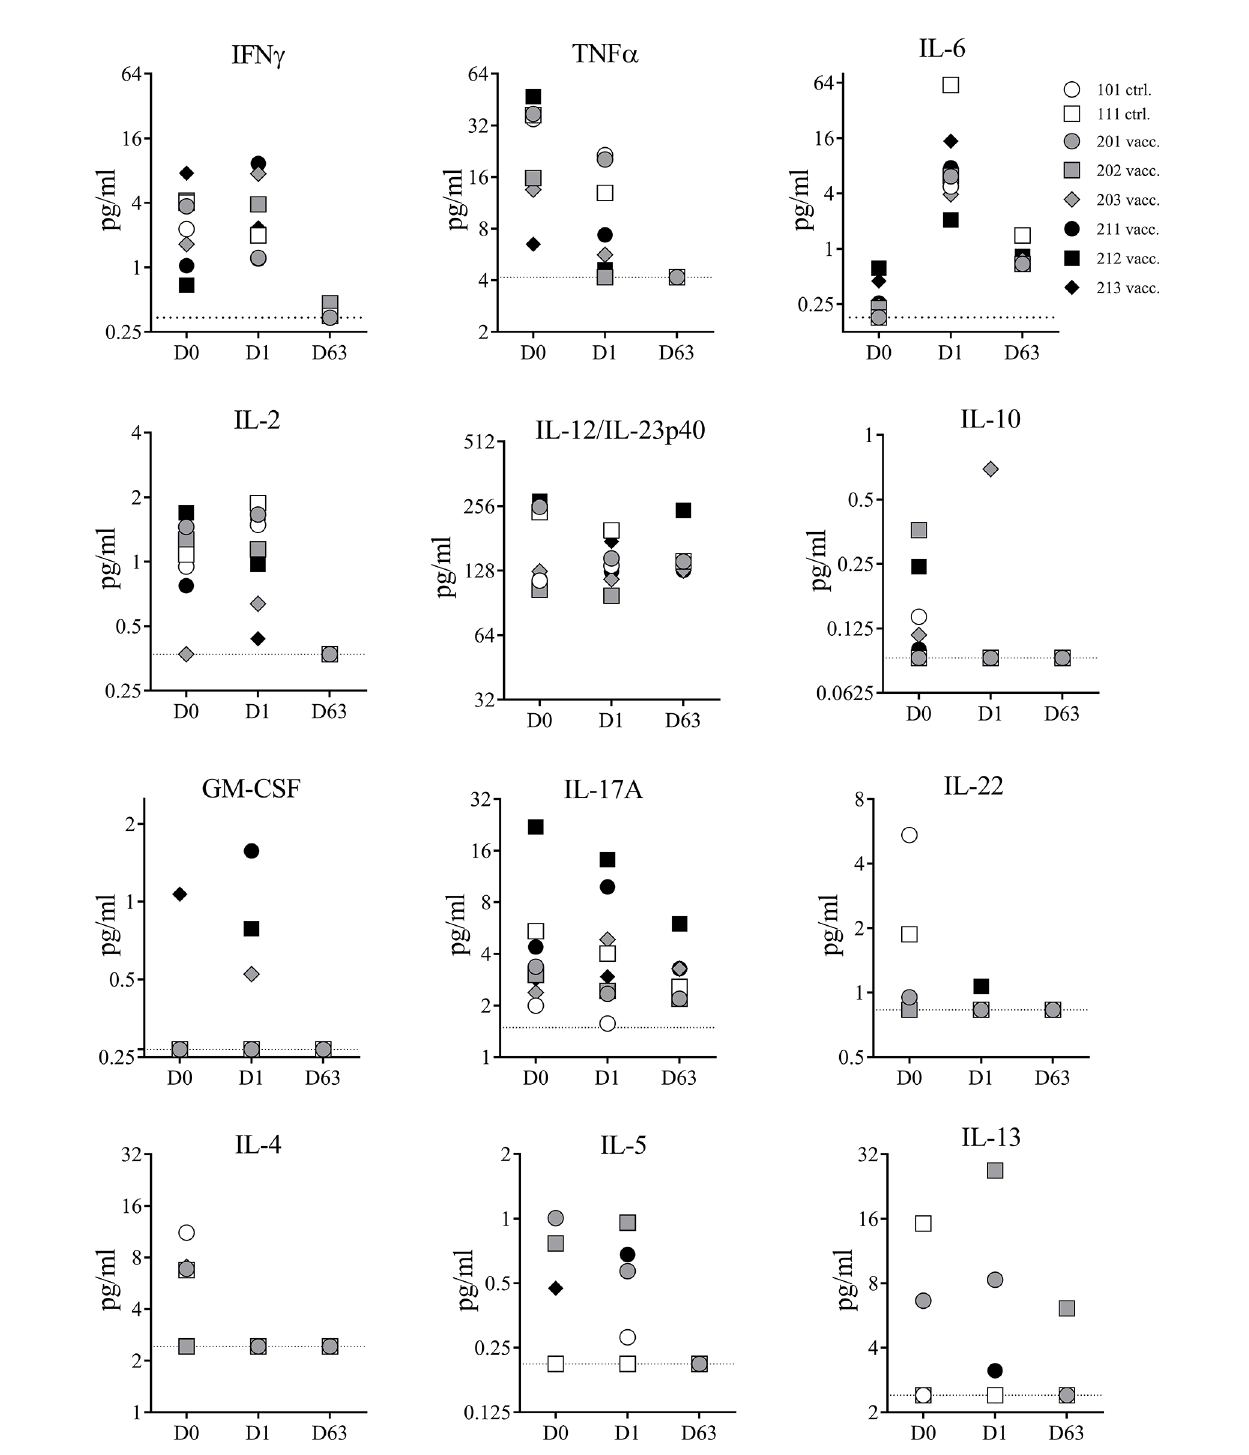
FIGURE 4 | Serum cytokines. Cytokines measured in serum samples of non-human primates (NHPs) collected before vaccination (D0), and on days 1 (D1) and 63 (D63) after vaccination. NHPs receiving 4-component vaccine (vacc.) and NHPs receiving adjuvant only (ctrl.). Dotted lines re fl ect limit of detection for respective cytokine. Data was analyzed with GraphPad PRISM